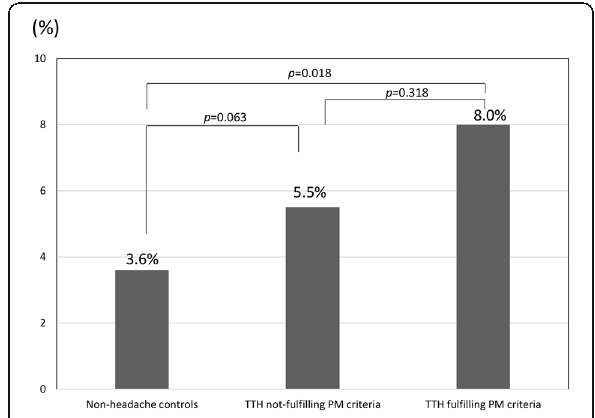
Fig. 2 Prevalence of RLS among individuals with non-headache, those with TTH fulfilling PM criteria, and those with TTH not fulfilling PM criteria. PM, probable migraine; RLS, restless legs syndrome; TTH, tension-type